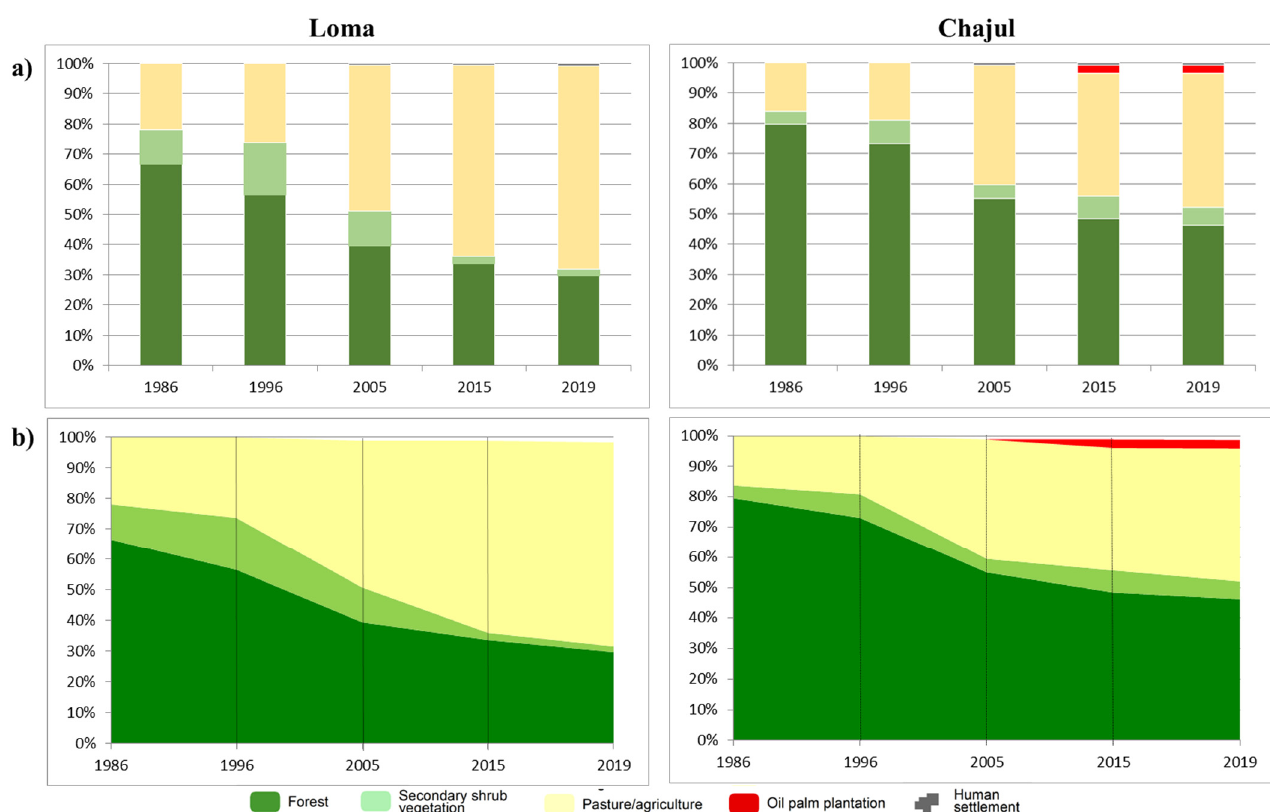
Figure 5. Graphical representation of land-use/cover change of the five studied periods from 1986 − 2019 in the ejidos of Loma and Chajul: ( a ) percentages of land-use classes; ( b ) land-use/cover transitions. Source: own elaboration based on this article’s data.